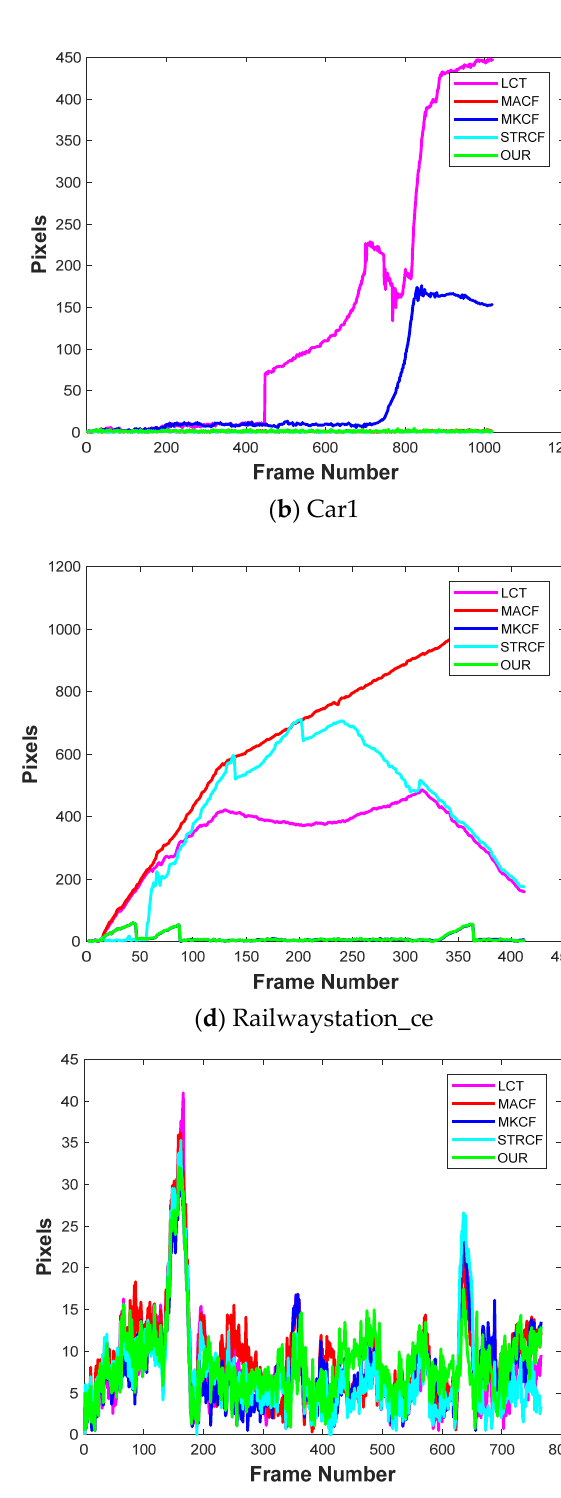
Figure 3. Quantitative analysis: comparison based on distance precision over a threshold of 20 pix- els. Six videos selected from OTB-50, OTB-100, and Colour-128 datasets.